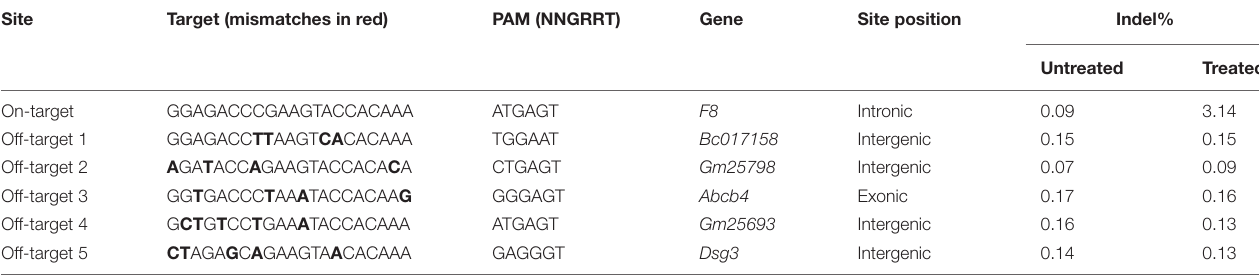
TABLE 1 | On-target and off-target analyses by NGS.